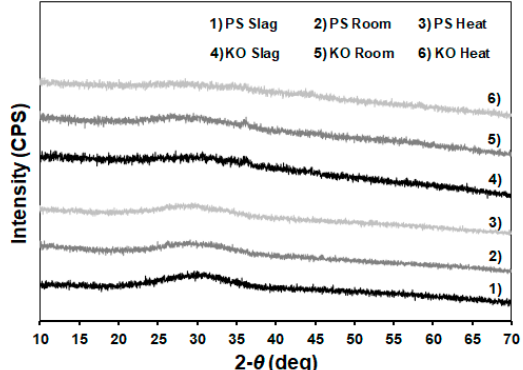
Figure 4. X-ray diffraction patterns of precursors (1 and 4) and alkali activated pastes made therefrom cured at room (2 and 5) and slightly elevated temperatures (60 °C for 2 d; 3 and 6). All the XRD patterns were collected after 28 days of curing.